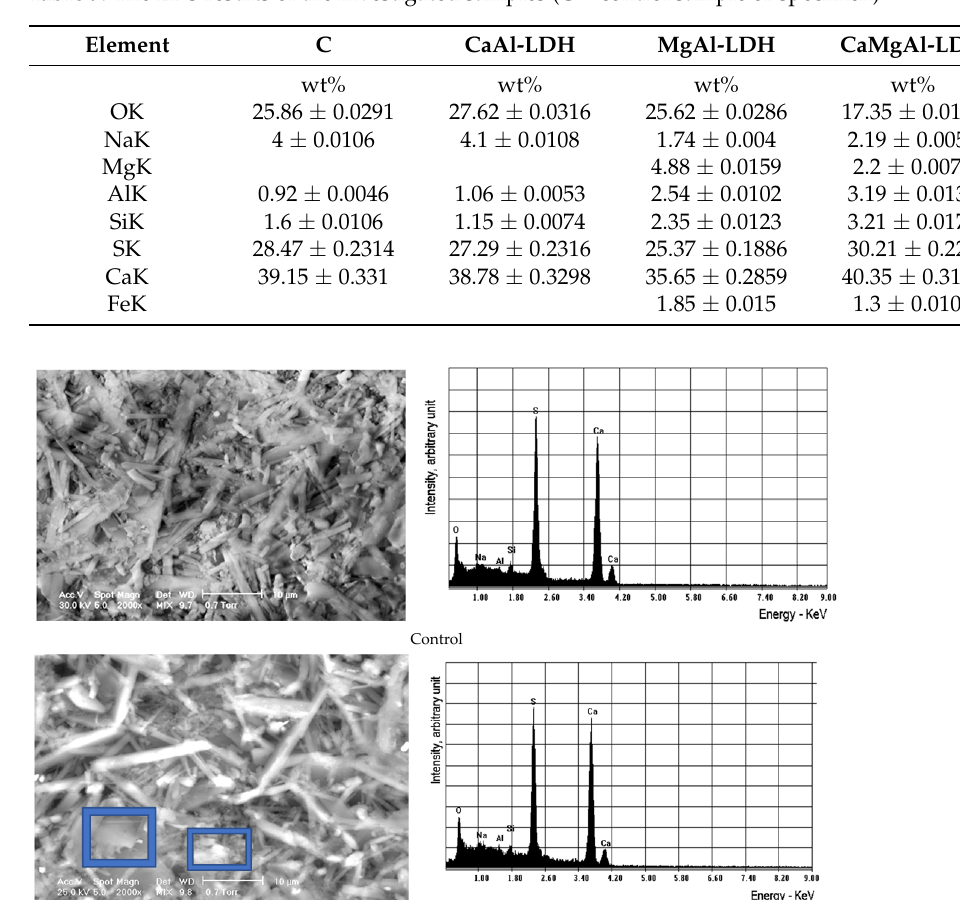
Table 9. The EDS results of the investigated samples (C = control sample or specimen).